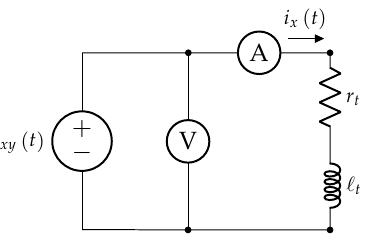
Figure 3. Circuit used for the identification of the resistance and inductance.